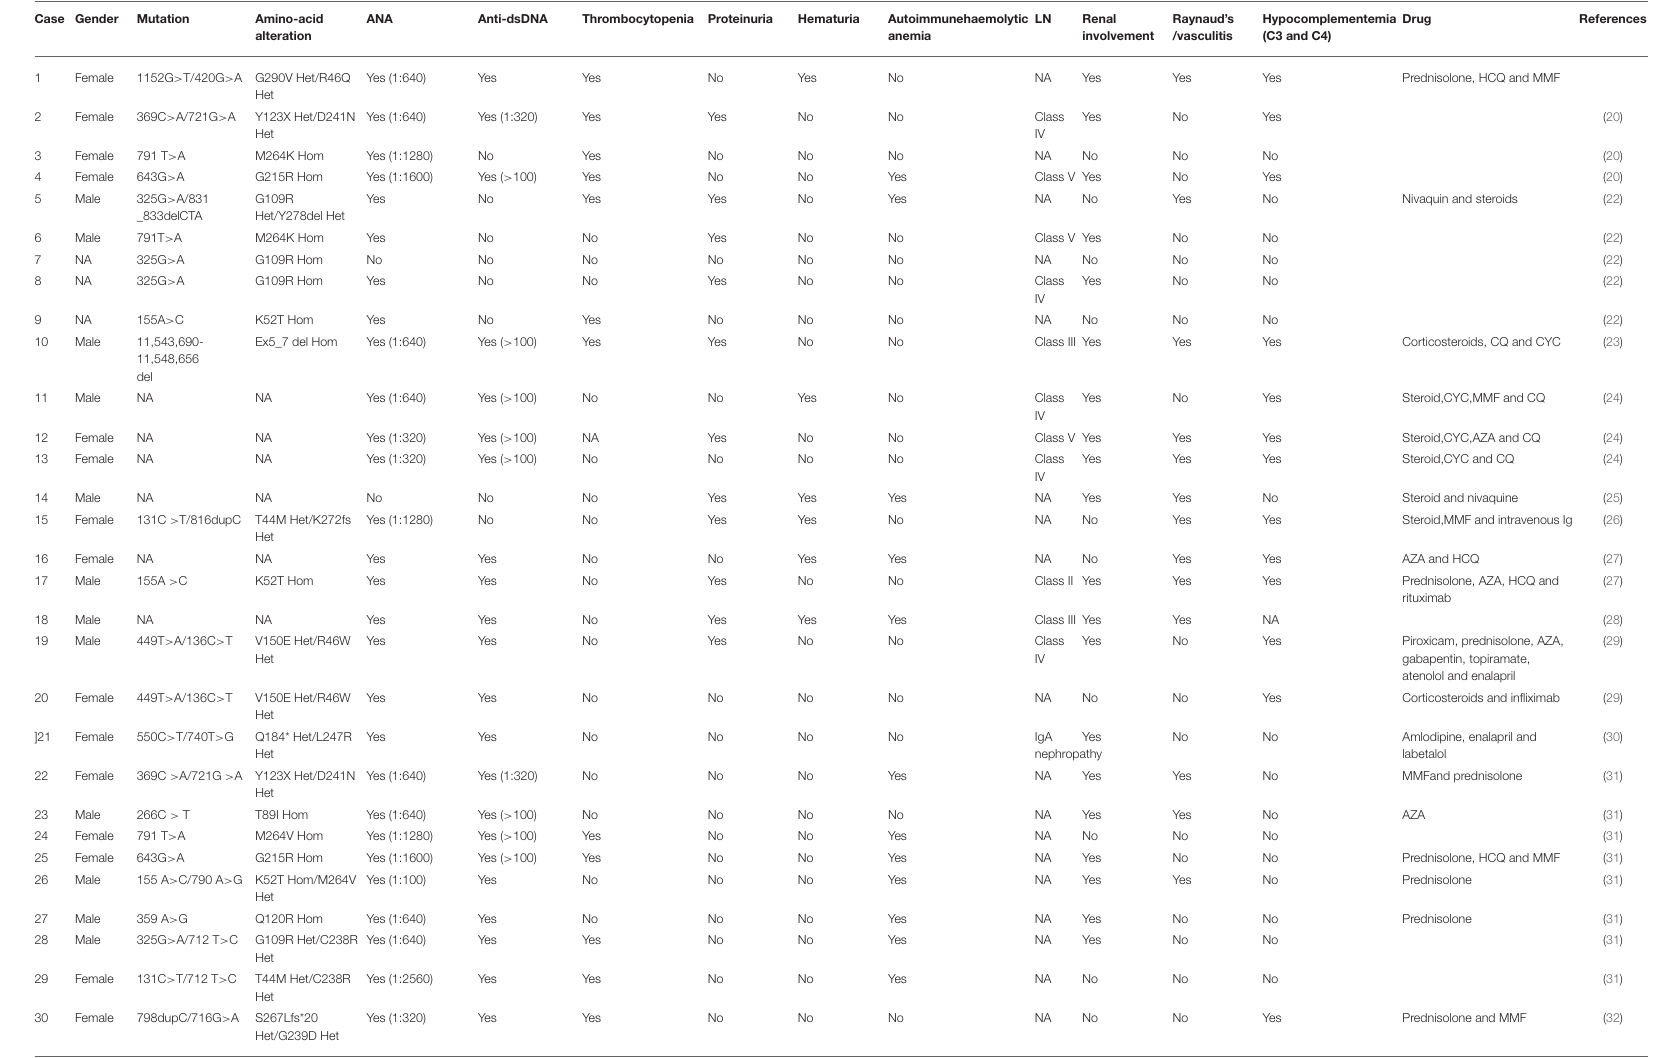
TABLE 2 | Cases of SPENCD associated with